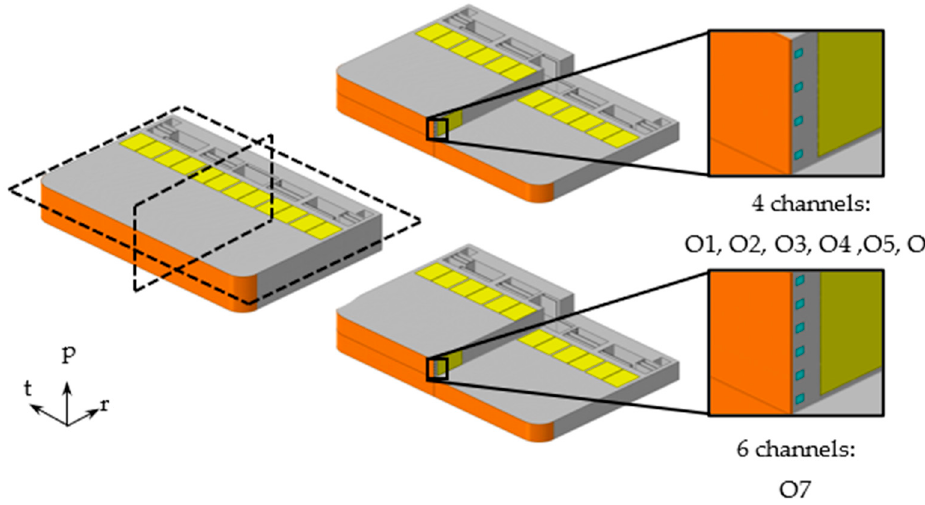
Figure 4. Models of the two elementary cells equipped with 4 and 6 cooling channels.